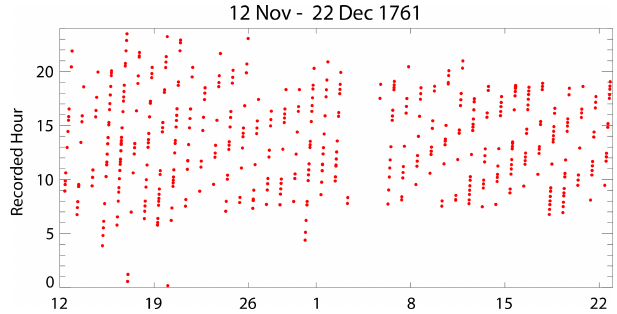
Figure 2. The recorded (local) times of Maskelyne’s measure- ments. Some measurements were made around the clock in the ear- lier part of the data set. However, they can be seen to be restricted to daylight hours in the latter